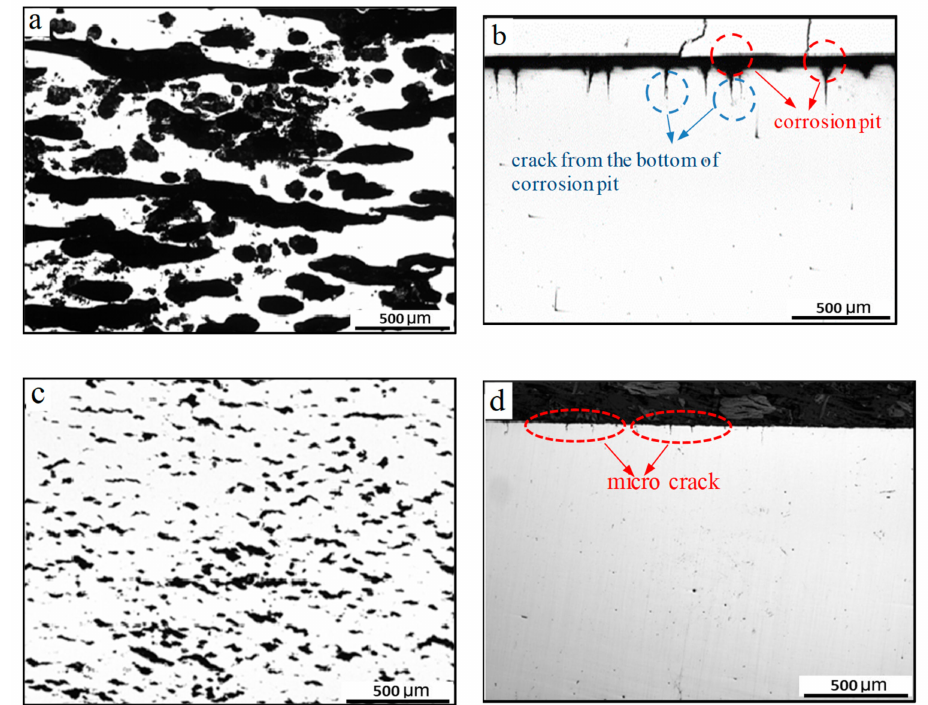
Figure 6. Metallography of bare specimen at the surface and cross-section after corrosion fatigue at 2 Hz: ( a , b ) 276 MPa and ( c , d ) 552 MPa.